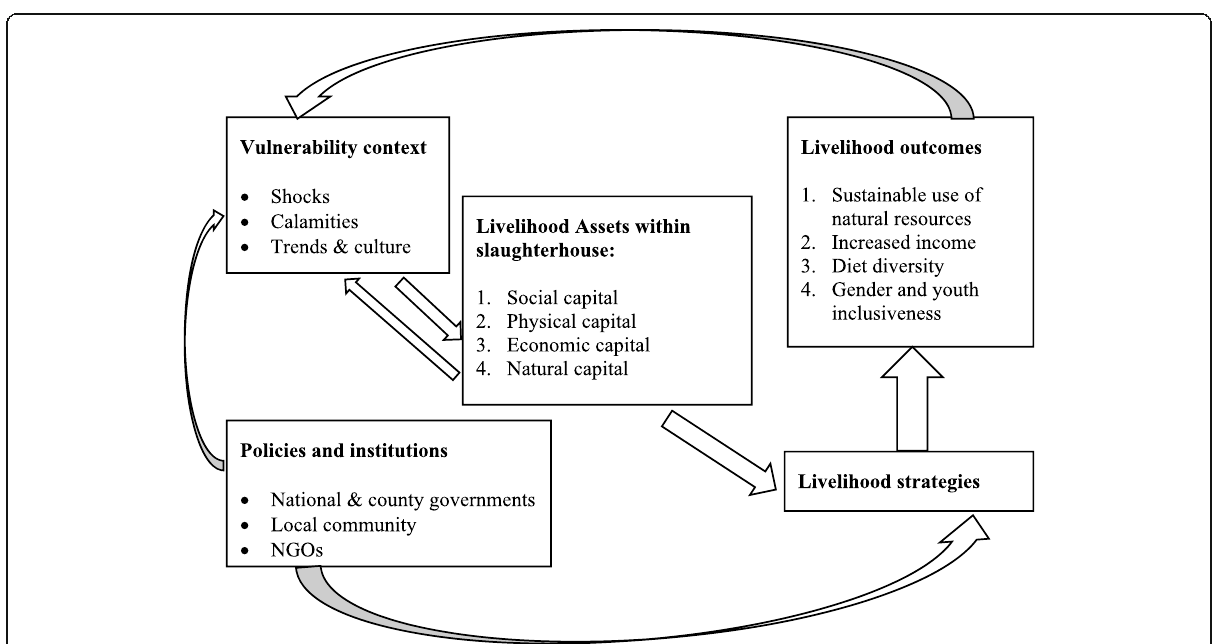
Fig. 1 The conceptual framework based on sustainable livelihoods approach model. modified from Serrat